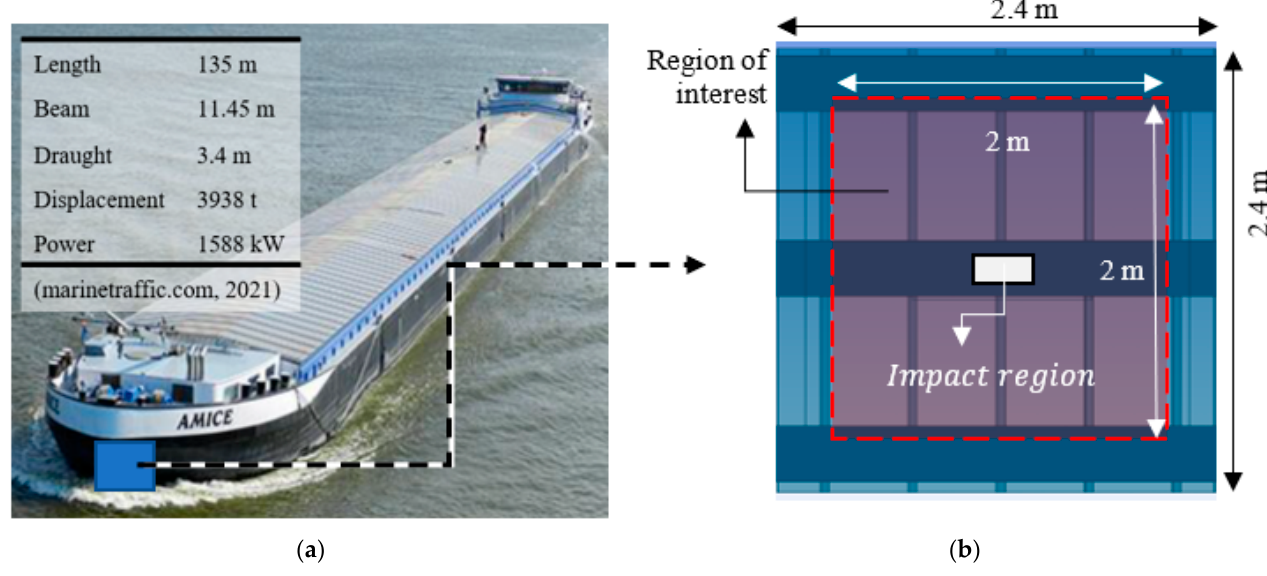
Figure 4. ( a ) An inland navigation barge called ‘Amice’ is used as basis to develop a reference hull plate shown in ( b ).